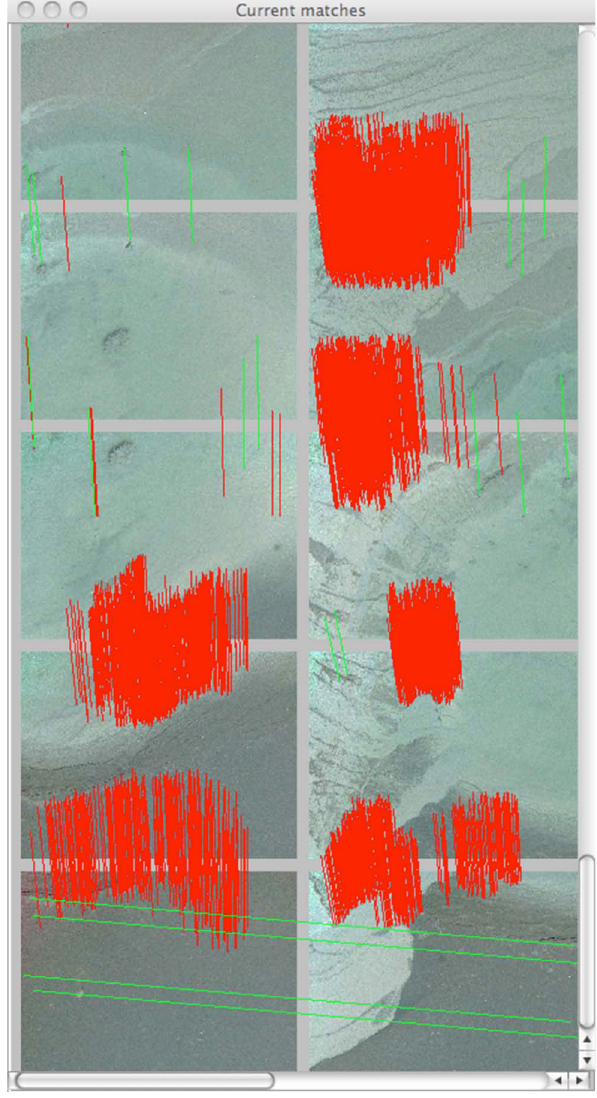
Fig. 10. View of the link editor of the LAPM tool; it gives the pos- sibility to visualize all matches and to identify potential unmatched overlapping images. The red lines represent links that were automat- ically detected, while the green lines are links which were manually created by the